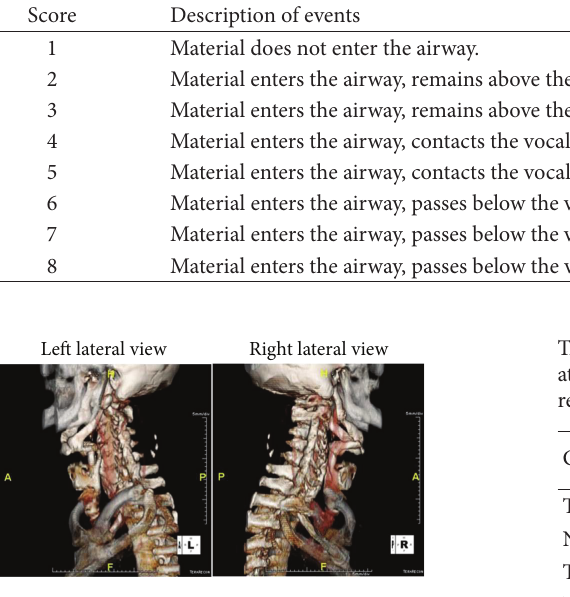
Figure 1: CT scan of the neck with 3-dimensional reconstruction of the larynx.